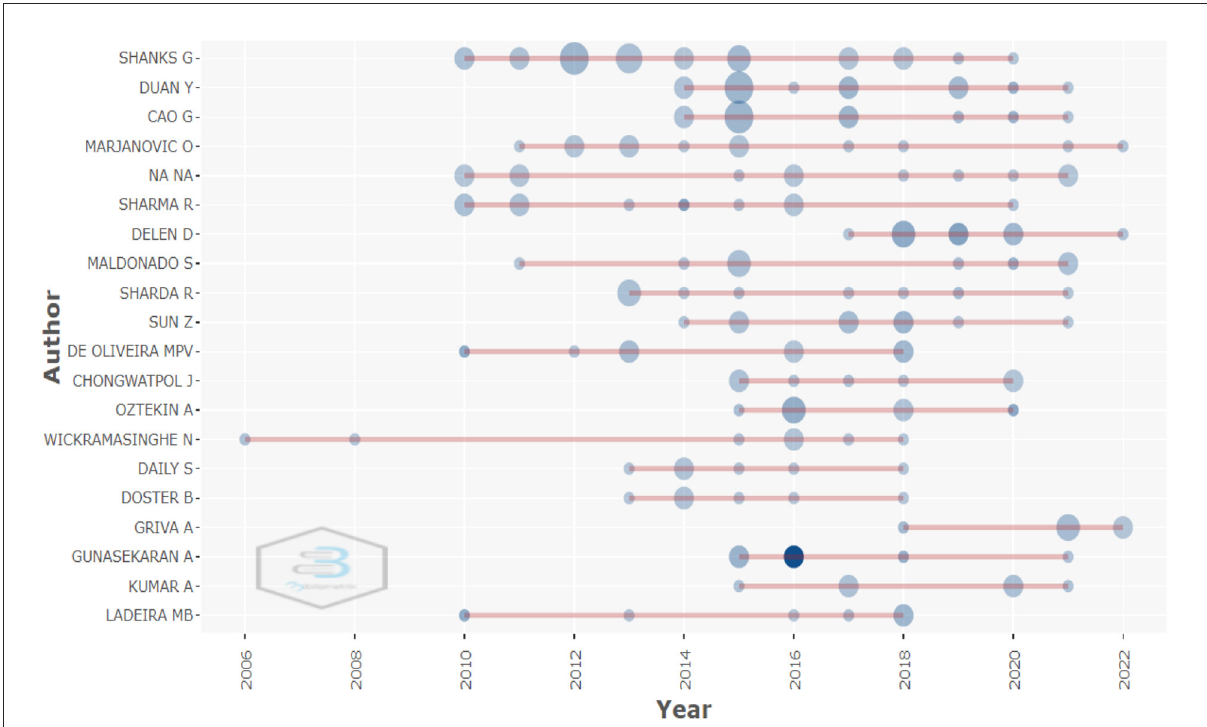
FIGURE5 Production of the main authors by year. Source: Own elaboration using